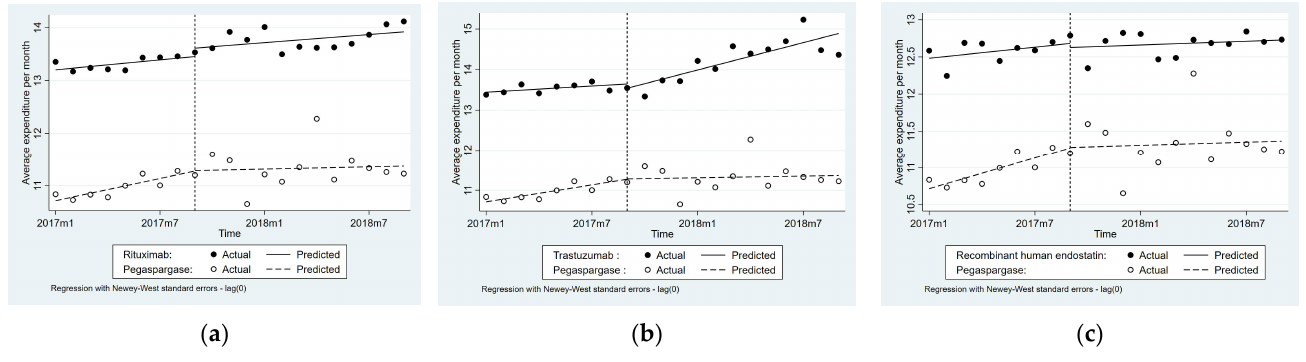
Figure 1. Average procurement expenditure (in 1000 RMB, log form) of three targeted anticancer drugs: ( a ) Rituximab; ( b ) Trastuzumab; ( c ) Recombinant human endostatin. For expenditure changes across eastern, middle, and western provinces, no signifi- cant differences were found between the expenditure of the intervention group and the comparison group of Rituximab and RHE. However, for Trastuzumab, the difference in the expenditure trend differed across regions ( β 7 = 0.07, p < 0.1 for eastern provinces; β 7 = 0.28, p < 0.05 for middle provinces; β 7 = 0.13, p < 0.1 for western region) (See Table S1 and Figure